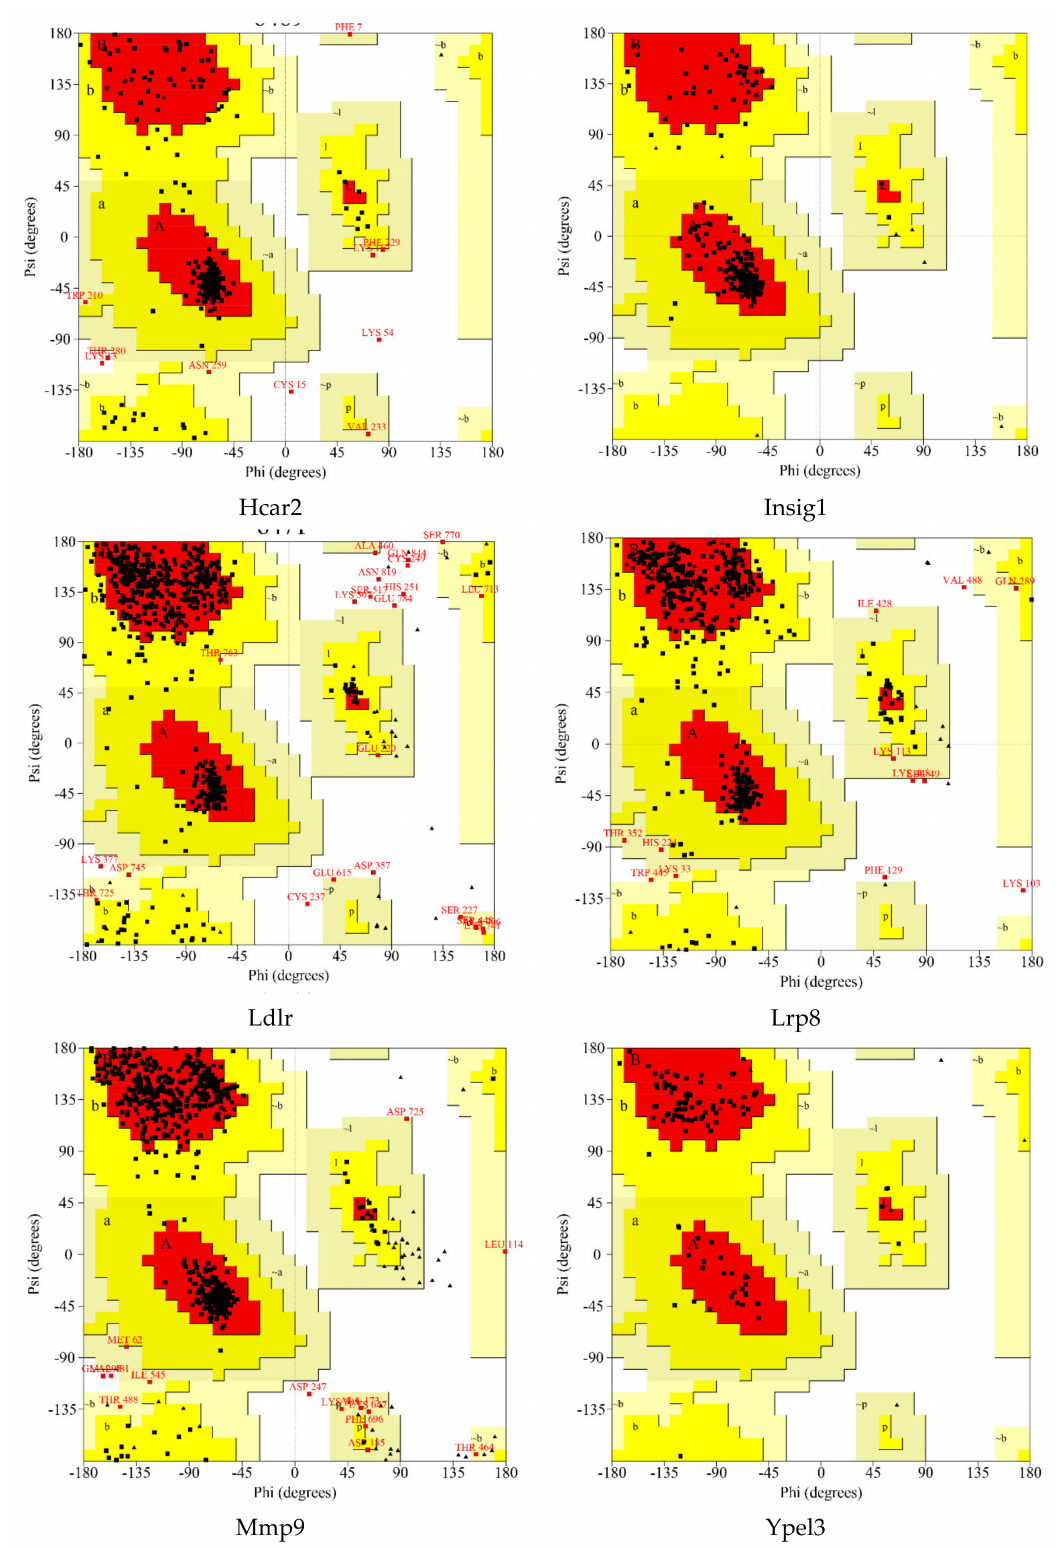
Figure 6. Ramachandran plot of the selected homology modeled 3D protein structures of DEGs. The di ff erent colored areas show ‘disallowed’ (beige), ‘generously allowed’ (yellow) and ‘most favored’ (red)